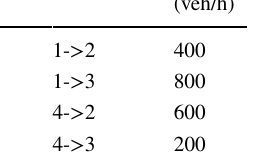
Table 2 Travel demand of